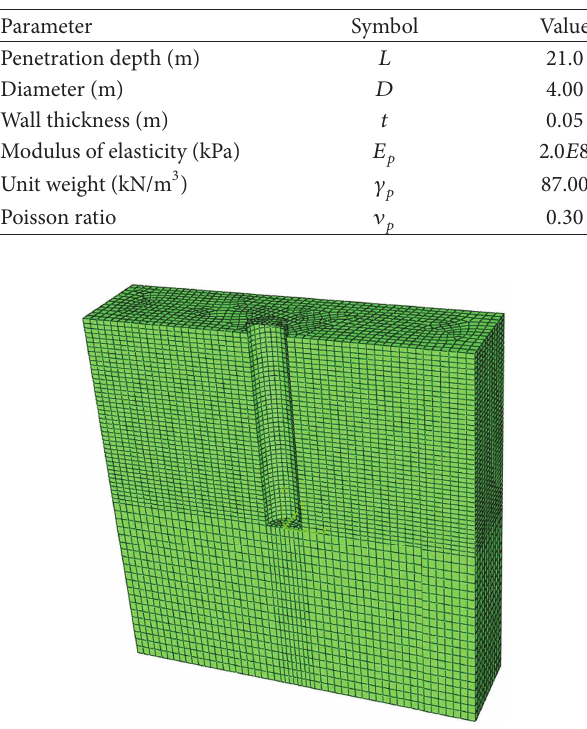
F 1: 3D �nite element model of the pile foundation.